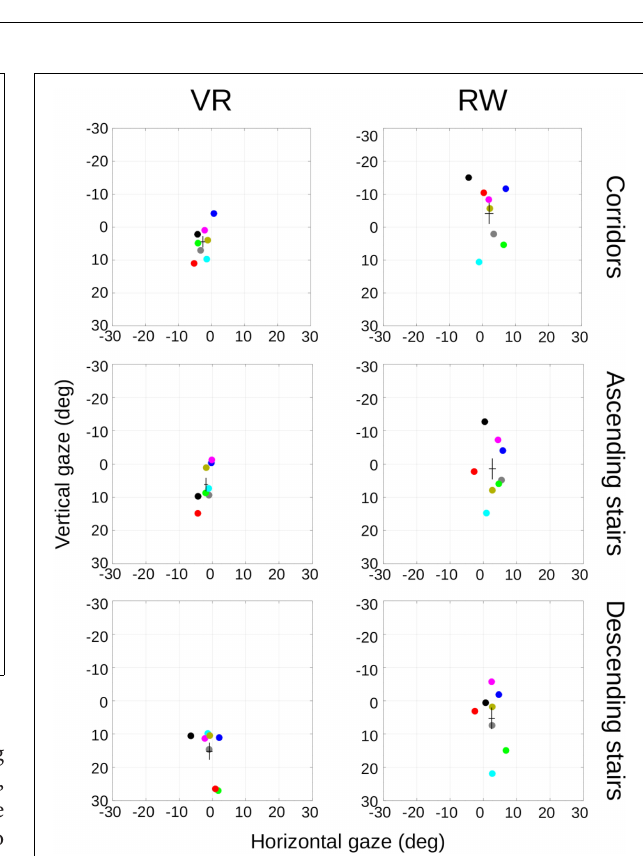
FIGURE 5 | Median of calibrated gaze positions in head-centered coordinates, separated by sector and world. Individual colored dots represent individual participants (matched across panels), black crosses represent mean and SEM across